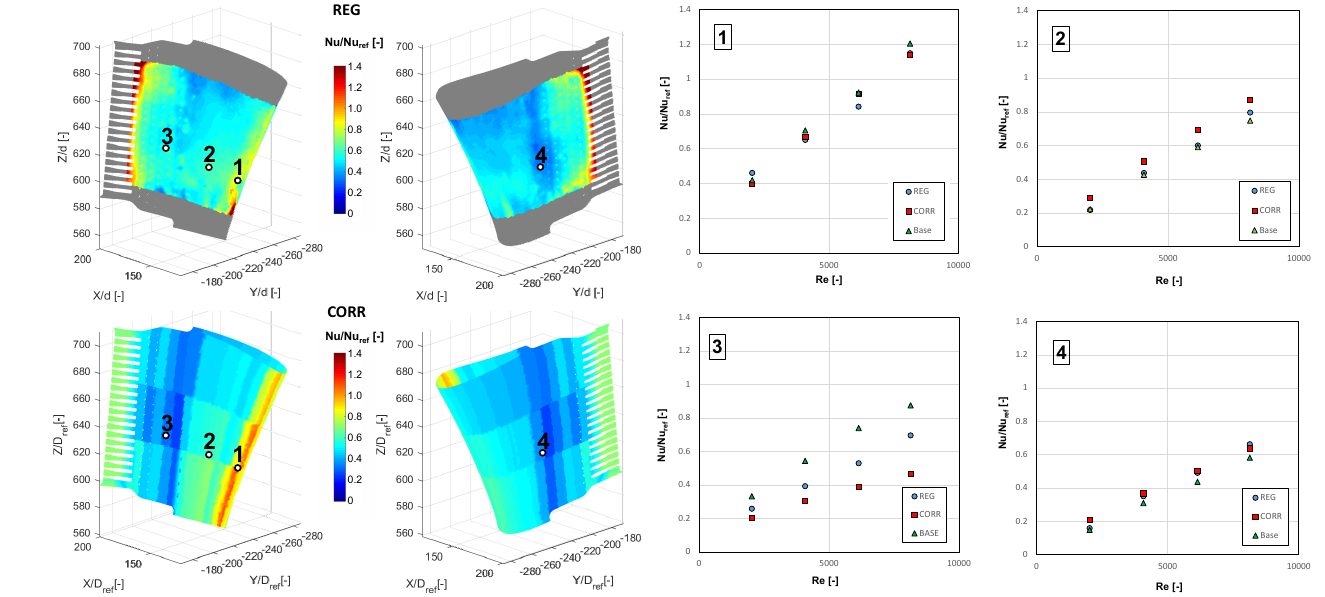
Figure 11. Comparison of regression and correlation for the Re =